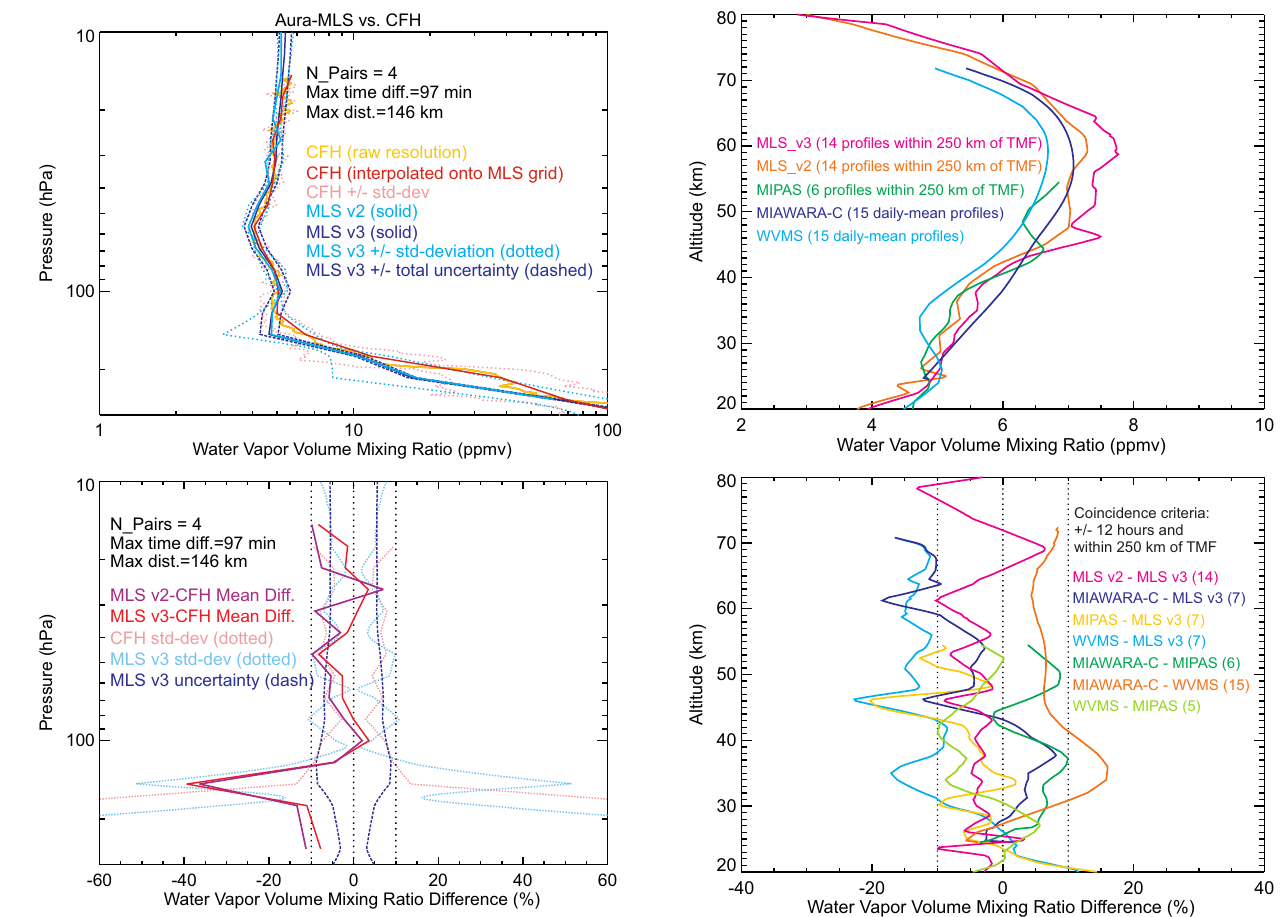
Fig. 13. Mean water vapor mixing ratio profiles (top) mea- sured during MOHAVE-2009 by the stratospheric sounders (MLS, MIAWARA-C, WVMS, and MIPAS) and mean differences (%) be- tween them (bottom). The numbers in parenthesis indicate the num- ber of